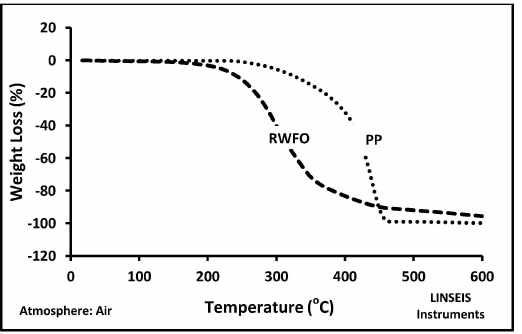
Figure 3. DSC analysis of ( a ) polypropylene ( b ) RWFO in nitrogen atmosphere with heating and cooling rate of 5 ˝ C/min to determine the melting and crystalline temperature ( T m and T c respectively).